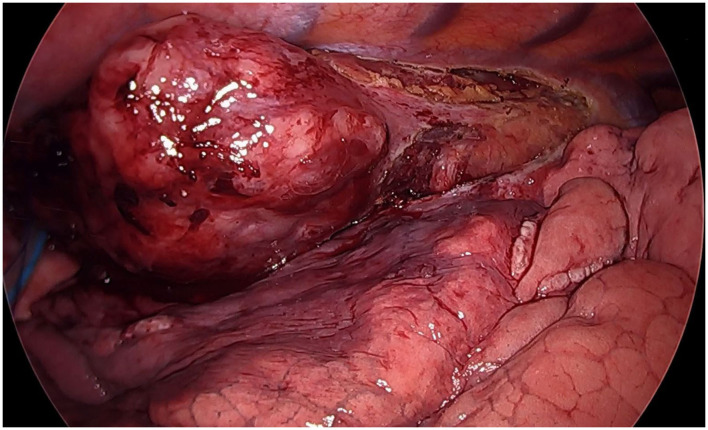
Thoracoscopic view (semi-prone position): huge neoplastic mass involving the infra-carenal esophagus.